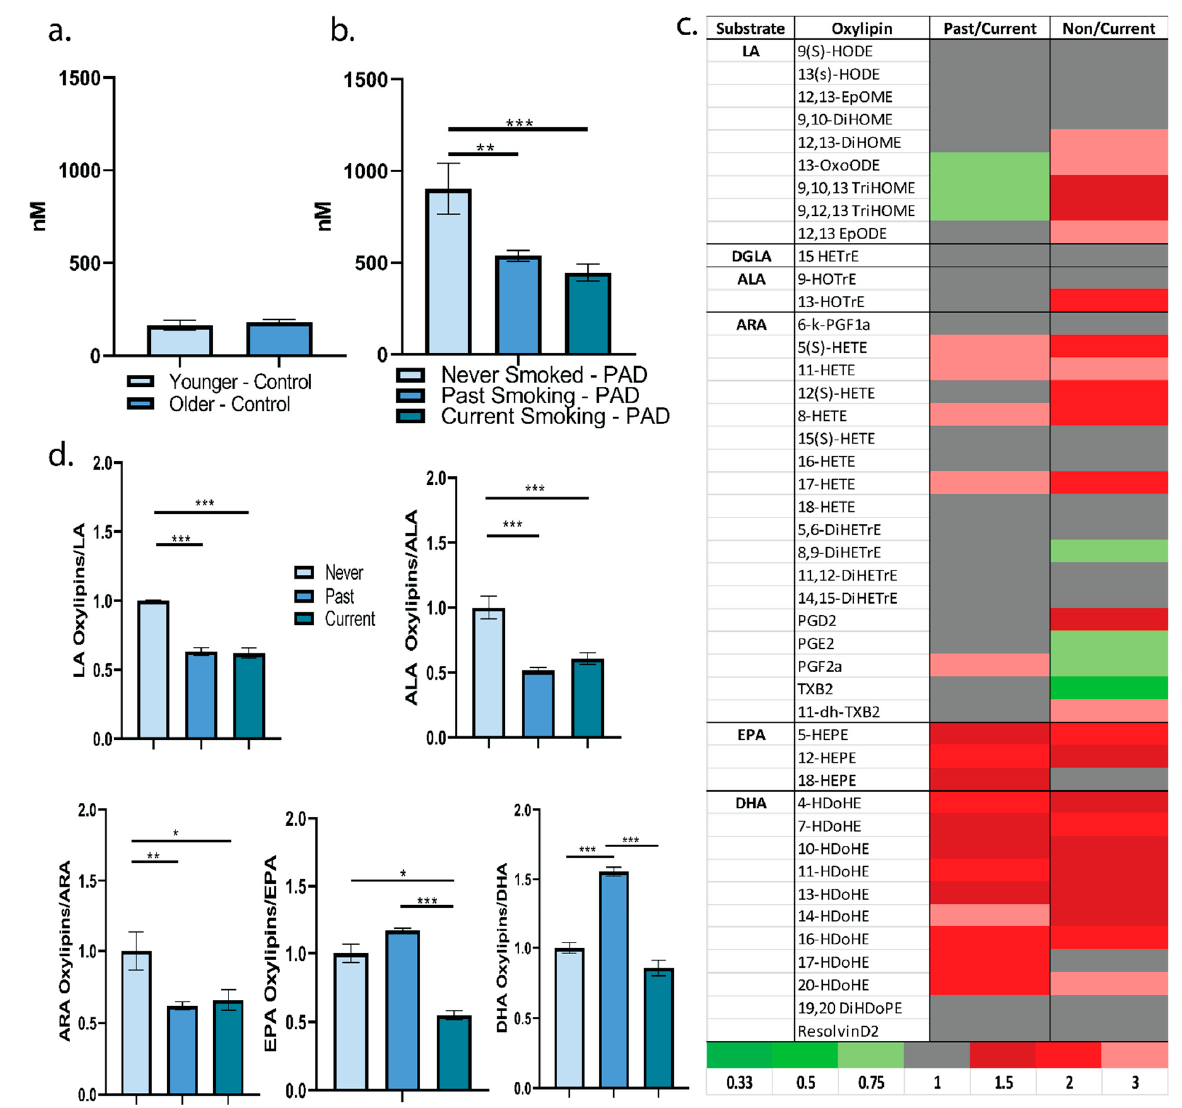
Figure 1. ( a ) Total plasma oxylipin concentration (nM) in nonsmoking individuals aged 19–28 years (younger) and 45–64 years (older). ( b ) Total plasma oxylipin concentration (nM) by smoking status in patients living with PAD. One way ANOVA (F = 9.334, p -value = 0.0002). Tukey’s post-hoc: **—Never Smoked vs. Past ( p = 0.0011), ***—Never Smoked vs. Current ( p = 0.0001). ( c ) Heat map representing fold differences in plasma concentrations of oxylipins by smoking status. ( d ) Ratio of plasma oxylipins to plasma fatty acid substrate relative to the Never Smoked group. LA: ANOVA ***—(F =